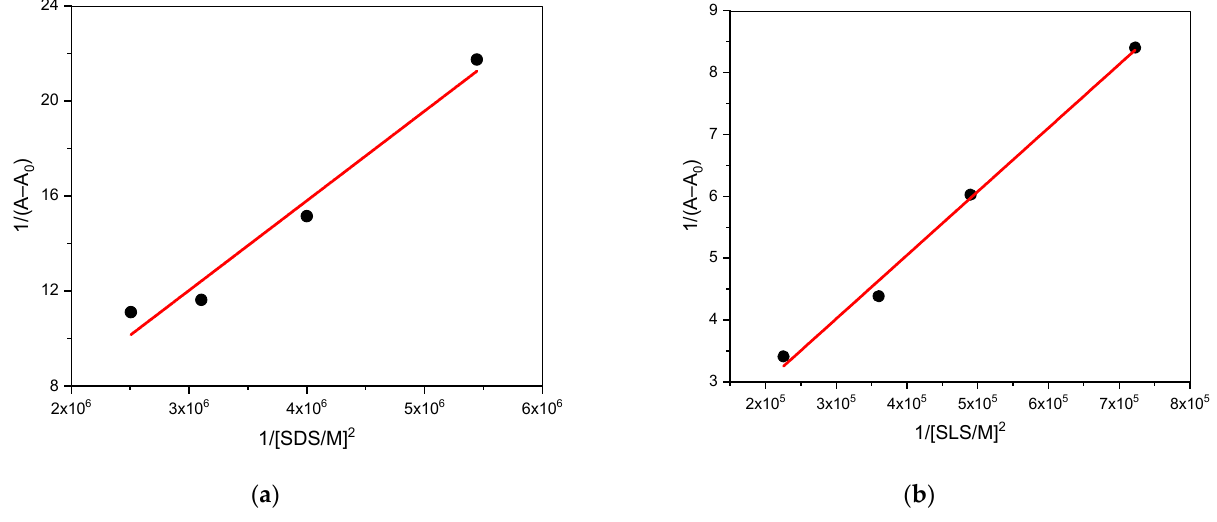
Figure 6. Benesi–Hildebrand plots for the interaction of TCH ( a ) SDS and ( b )